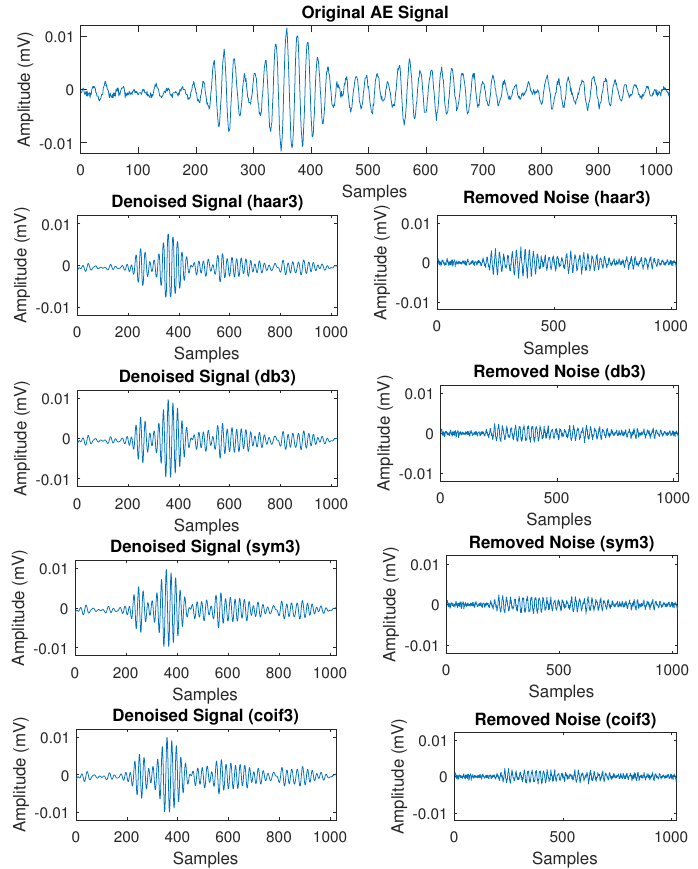
Figure 8. Noise reduction by ND-SWT using haar3, db3, sym3 and coif3